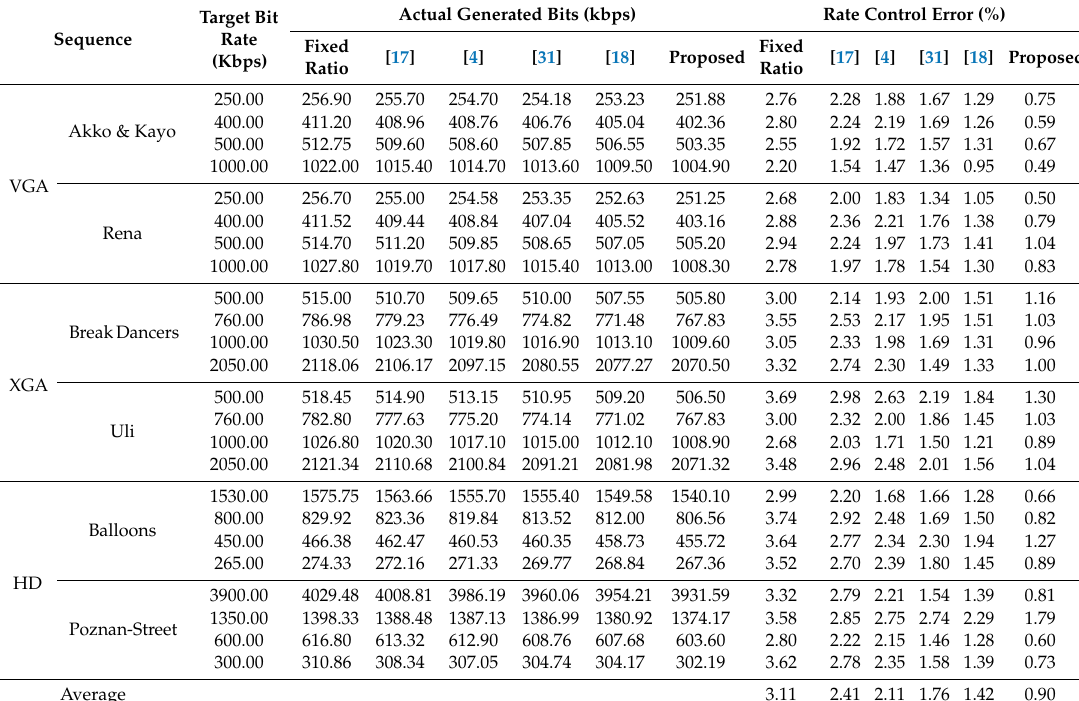
Table 1. Simulation results of our method.